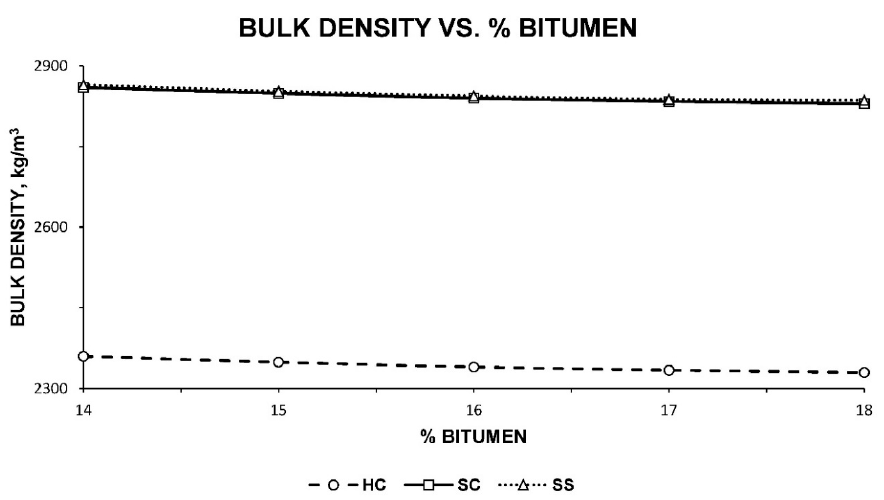
Figure 6. Bulk density of the HC, SC, and SS families of bituminous mixtures according to the percentage of bitumen.